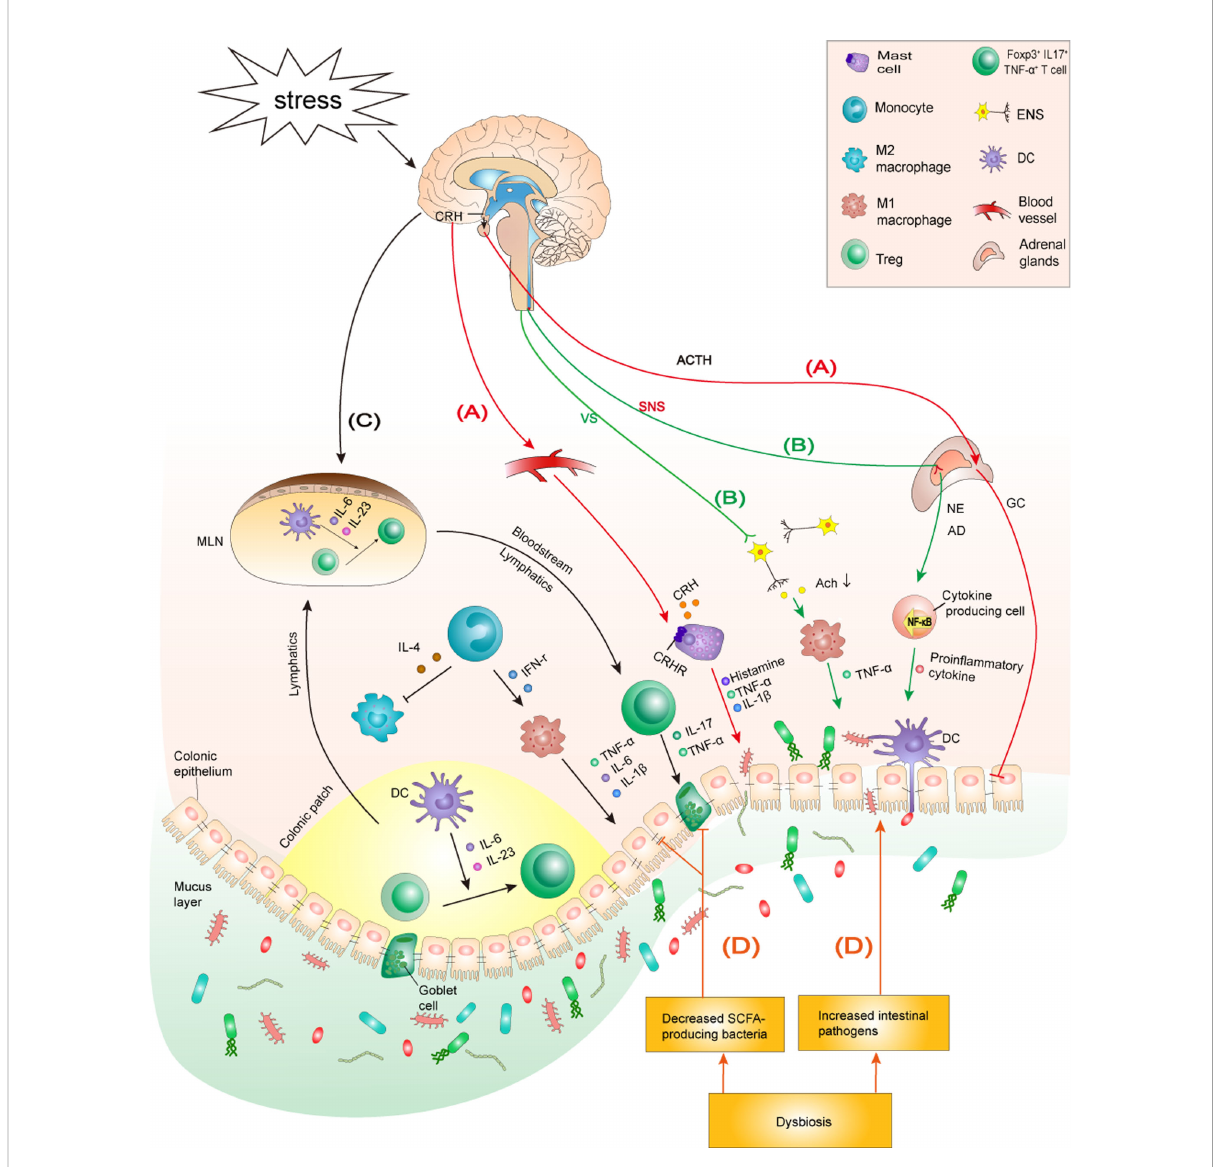
FIGURE 1 The mechanism by which chronic psychological stress aggravates IBD. (A) Stress activates the HPA axis: Stress induces the hypothalamus to release CRH, which triggers the release of ACTH from the hypophysis. ACTH subsequently initiates GC over-synthesis and release in the adrenal cortex. CRH reaches the colon through the blood and binds to CRHRs on the surface of MCs to promote degranulation and the production of proin fl ammatory cytokines IL-1 b and TNF- a , which, in turn, increase the permeability of the colonic epithelial barrier. Furthermore, the overproduction of GC reduces tight junction protein expression between colonocytes, impairing the intestinal barrier function. (B) Stress activates the SNS but inhibits the vagus nerve: The sympathetic nervous system is stimulated by stress, which causes the adrenal medulla to secrete excessive AD and NE, promoting the activation of NF- k B signaling and mediating higher secretion of in fl ammatory cytokines in peripheral tissues. The inhibition of the anti-in fl ammatory effect of the vagus nerve promotes macrophage-induced TNF- a production, which aggravates the progress of colitis. (C) Stress is involved in innate and adaptive immune dysfunction by regulating speci fi c immune cells and cytokine production: Stress induces macrophages to in fi ltrate the colon and polarize into an M1 phenotype. Additionally, stress promotes intestinal DCs to secrete IL-6 and IL-23, which induces Tregs to differentiate into a Foxp3 + IL17 + TNF- a + T cell phenotype. M1 macrophages and Foxp3 + IL17 + TNF- a + T cells secrete corresponding in fl ammatory cytokines to aggravate the colonic in fl ammatory response. (D) Stress induces microbiome community dysbiosis: Stress causes dysbiosis by increasing intestinal pathogens and decreasing SCFA-producing bacteria in the intestine. Intestinal pathogens can cause and exacerbate colitis by impairing the intestinal barrier and activating intestinal immunity. Decreased SCFAs lead to reduced tight junction protein expression and goblet cell numbers, which in turn lead to impaired intestinal barrier function and aggravated colonic in fl ammation. HPA axis, hypothalamic-pituitary-adrenal axis; CRH, corticotropin-releasing hormone; ACTH, adrenocorticotropic hormone; GC, glucocorticoids; CRHRs, CRH receptors; ANS, autonomic nervous system; SNS, sympathetic nervous system; AD, adrenaline; NE, noradrenaline; VS, vagus nerve; MCs, mast cells; SCFAs: short-chain fatty acids; MLN, mesenteric lymph node; ENS, enteric nervous